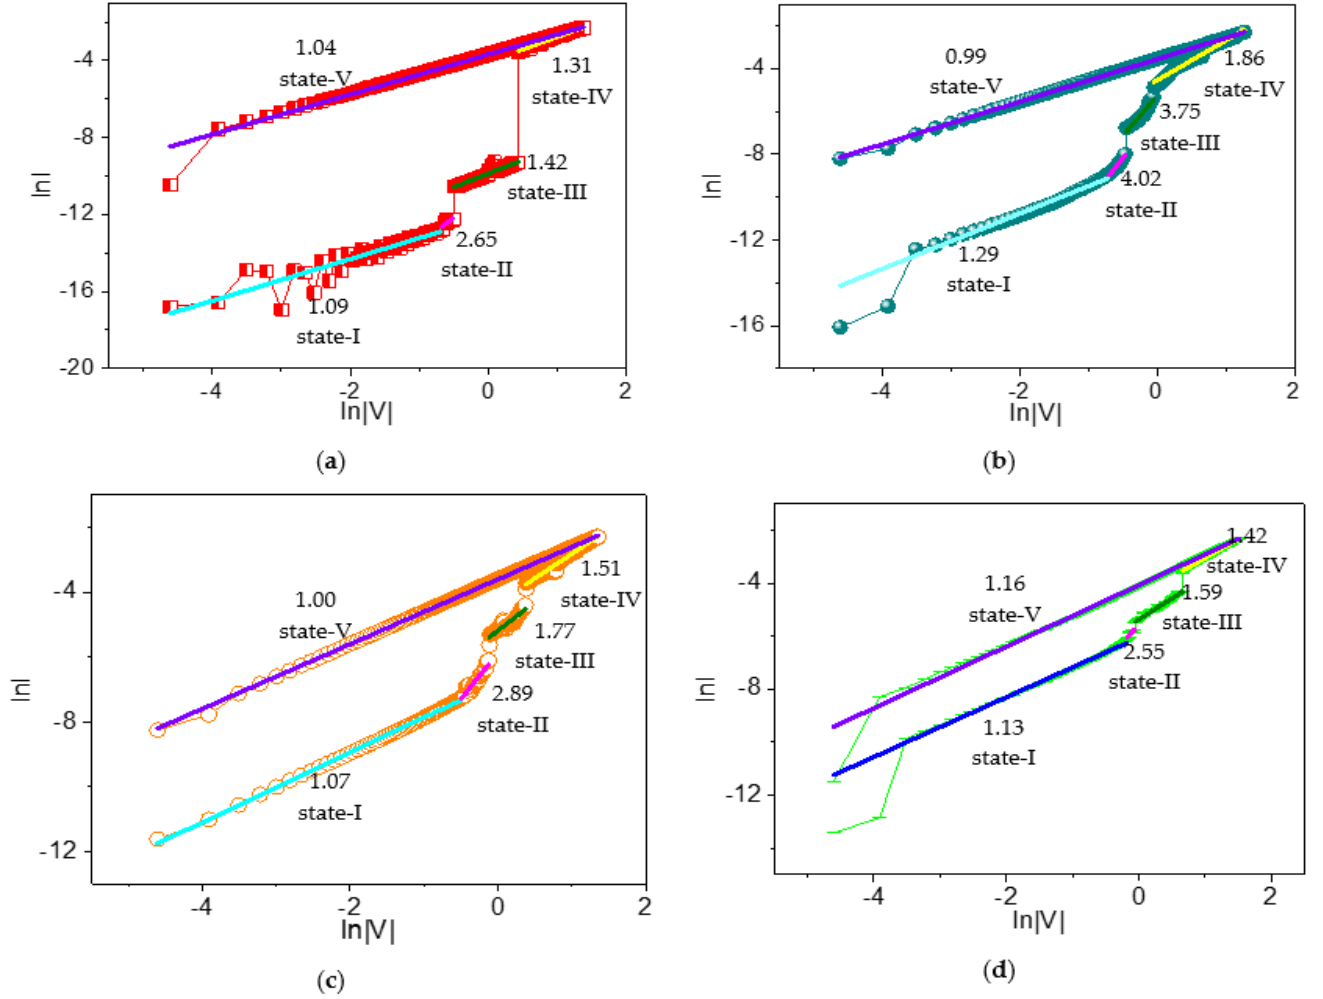
Figure 12. Log–log plots of the I-V data for ( a ) ITO/B1/Ni, ( b ) ITO/B2/Ni, ( c ) ITO/B3/Ni, and ( d ) ITO/B4/Ni during the SET